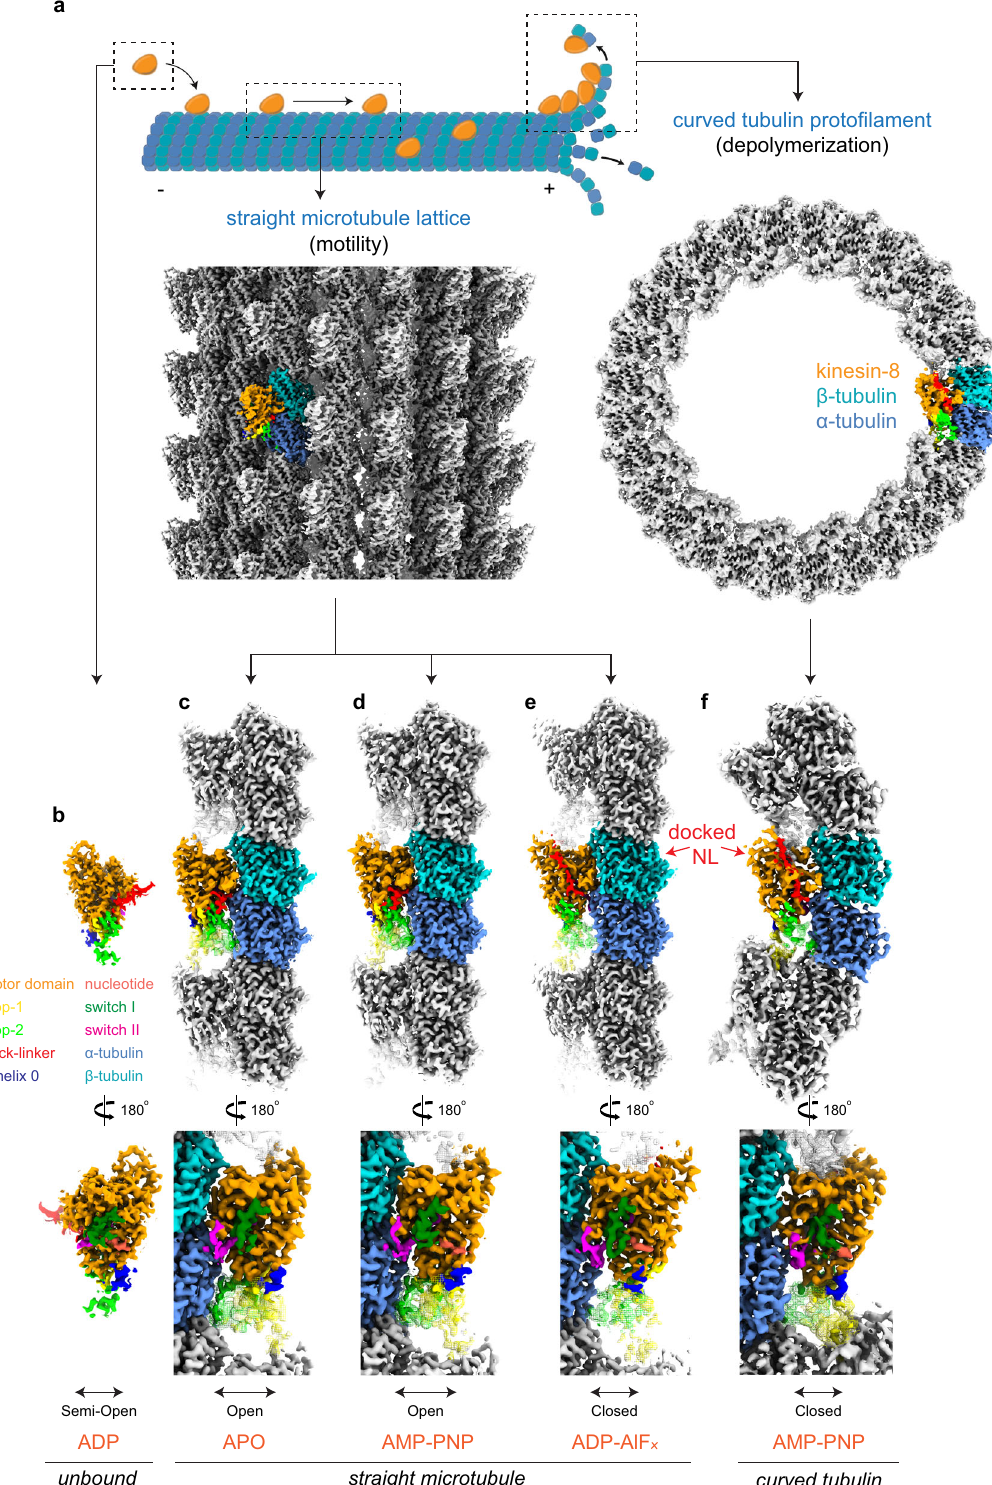
Fig. 1 Structures of microtubule-unbound, microtubule-bound, and curved tubulin-bound Ca Kip3. a Top — Cartoon representation of catalytic intermediates of Ca Kip3 ’ s motility and microtubule depolymerization cycles. Bottom — Example of a Ca Kip3-decorated microtubule (MT- Ca Kip3-MDC- ANP) cryo-EM map and the full Ca Kip3-decorated dolastatin-tubulin-ring cryo-EM map. b X-ray crystallographic density of Ca Kip3-MDN in the ADP state. c – e Cryo-EM maps of microtubule-bound Ca Kip3-MDC in the APO, AMP-PNP, and ADP-AlF x nucleotide states. f Cryo-EM maps of curved tubulin-bound Ca Kip3-MDC in the AMP-PNP state. Map surfaces are colored regionally according to the segment of the fi tted protein model they enclose: α -tubulin (corn fl ower blue), β -tubulin (sky blue), kinesin motor core (orange), Switch I loop (forest green), loop-11 of Switch II (magenta), neck-linker (red), nucleotide (tomato), loop-1 (yellow), loop-2 (lime green), helix-0 (dark blue). The fi gure was prepared with UCSF ChimeraX 87